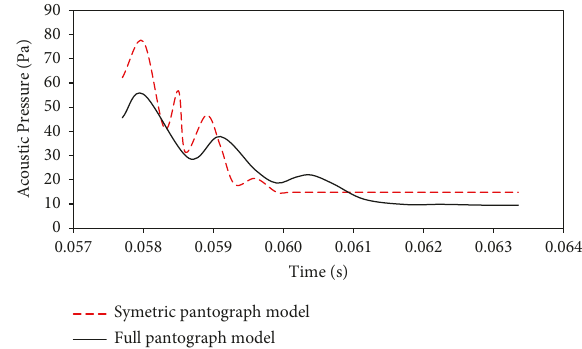
Figure 7: Comparison between the acoustic pressure levels cal- culated for a symmetric and full-scale model of SSS87 pantograph at a speed of 300km/hr.